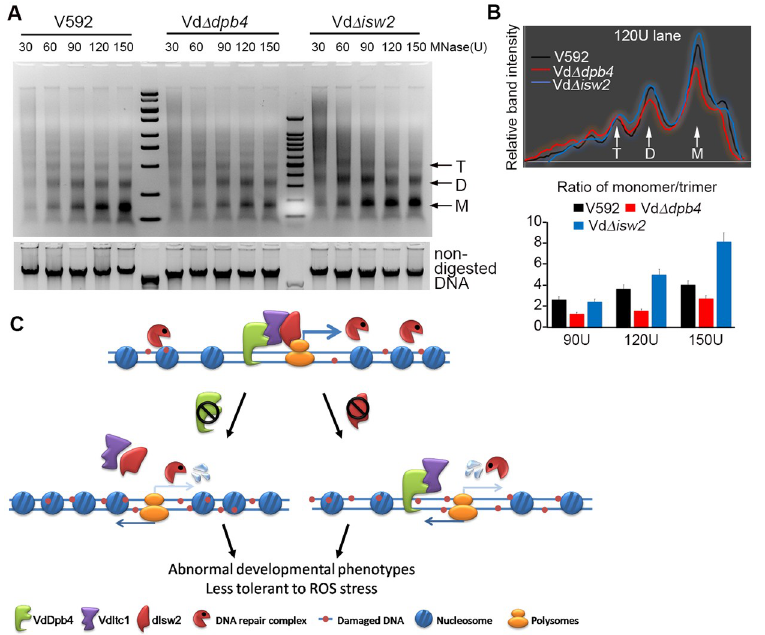
Fig 6. VdDpb4 is essential for chromatin structure maintenance. A. MNase digestion patterns in the wild-type V592, Vd Δ dpb4 and Vd Δ isw2 mutant cells synchronized at the G2/M phase of the cell cycle. The gel shows a representative tendency of three independent experiments with 20 min MNase digestion. M: DNA size standard, T: trinucleosome, D: dinucleosome, M: mononucleosome. B. Relative band intensity profiles of the 120 U MNase lanes for V592, Vd Δ dpb4 and Vd Δ isw2 . Quantitative analysis of MNase accessibility expressed as the ratio of mono- to trinucleosome signals at different concentrations of MNase is shown on the right. Error bars represent standard deviations. C. Proposed model for the VdDpb4- and VdIsw2-mediated complex control of the development and pathogenicity of V . dahliae . The interaction between VdDpb4 and VdIsw2 plays a role in maintaining normal chromatin structure, which is crucial for DNA repair and gene expression. However, depletion of VdDpb4 or VdIsw2 disrupts chromatin structure, which causes an imbalance in gene expression and impedes DNA damage repair and ultimately leads to an abnormal phenotype and less tolerance to ROS stress during development and plants